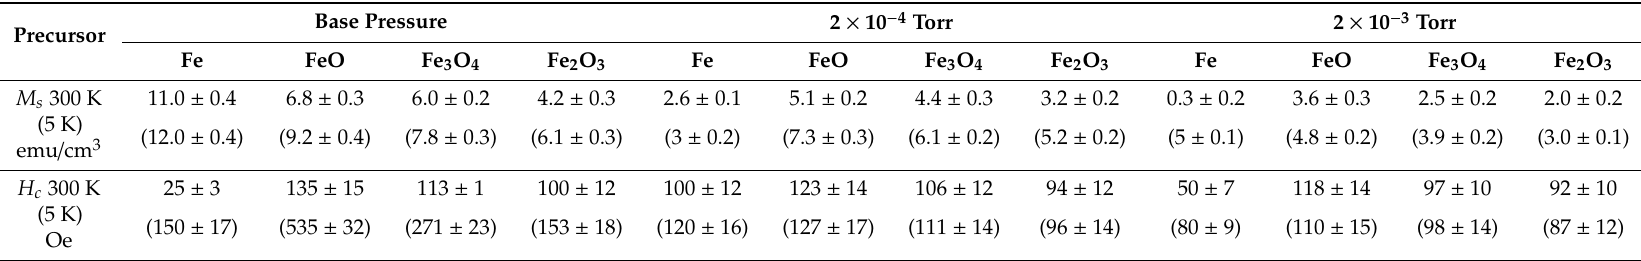
Table 2. The values of M s and H c measured at 300 K and at 5 K for the di ff erent precursors and oxygen pressure in the pulsed laser deposition (PLD)